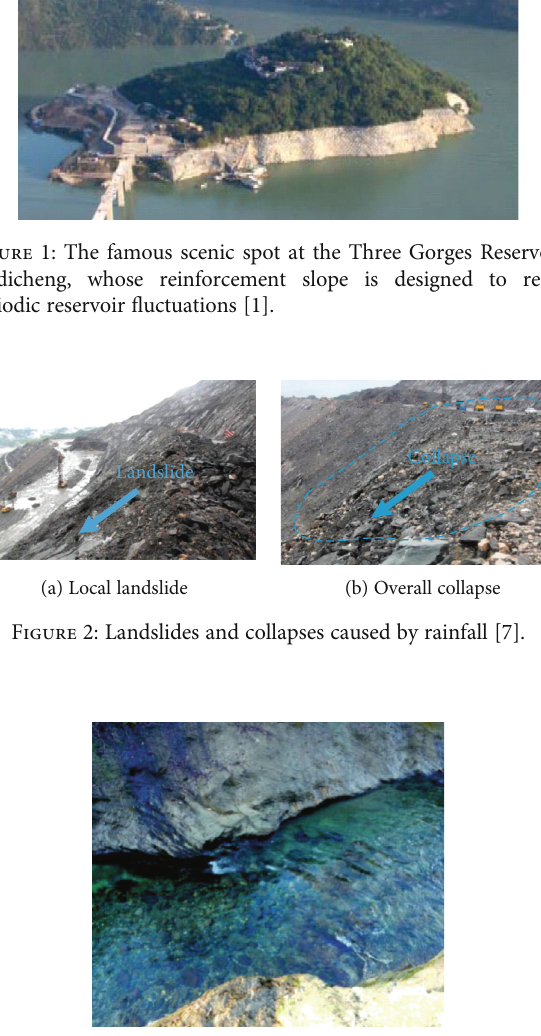
Figure 3: The bedrock of Saranbe River, experiencing seasonal cycles of dry and wet